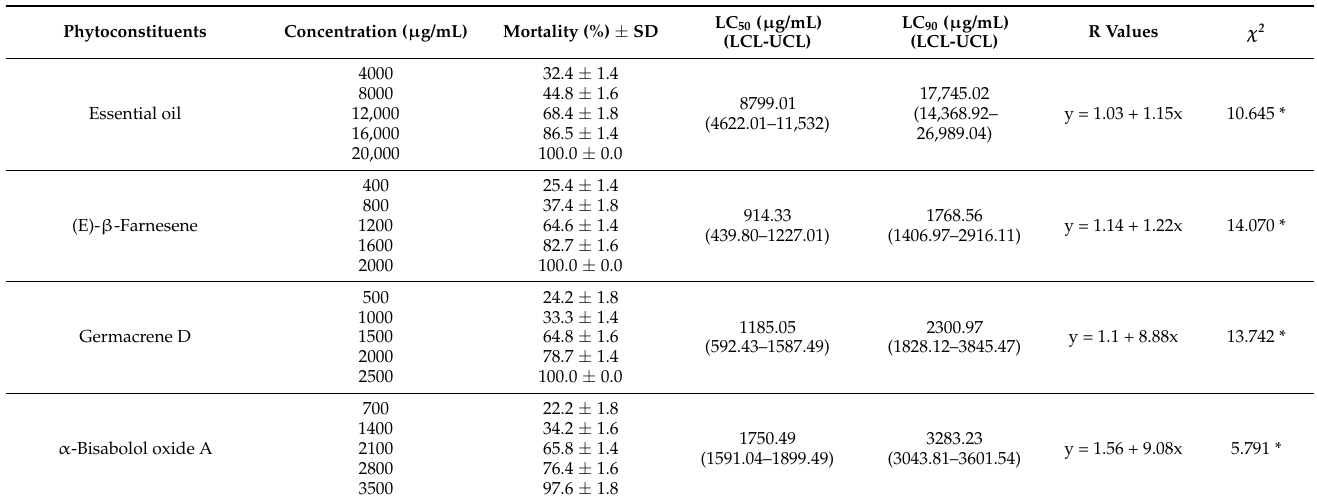
Table 7. The effect of Matricaria chamomilla essential oil and its major phytoconstituents against aquatic non-target fauna (NTF) Gambusia affinis